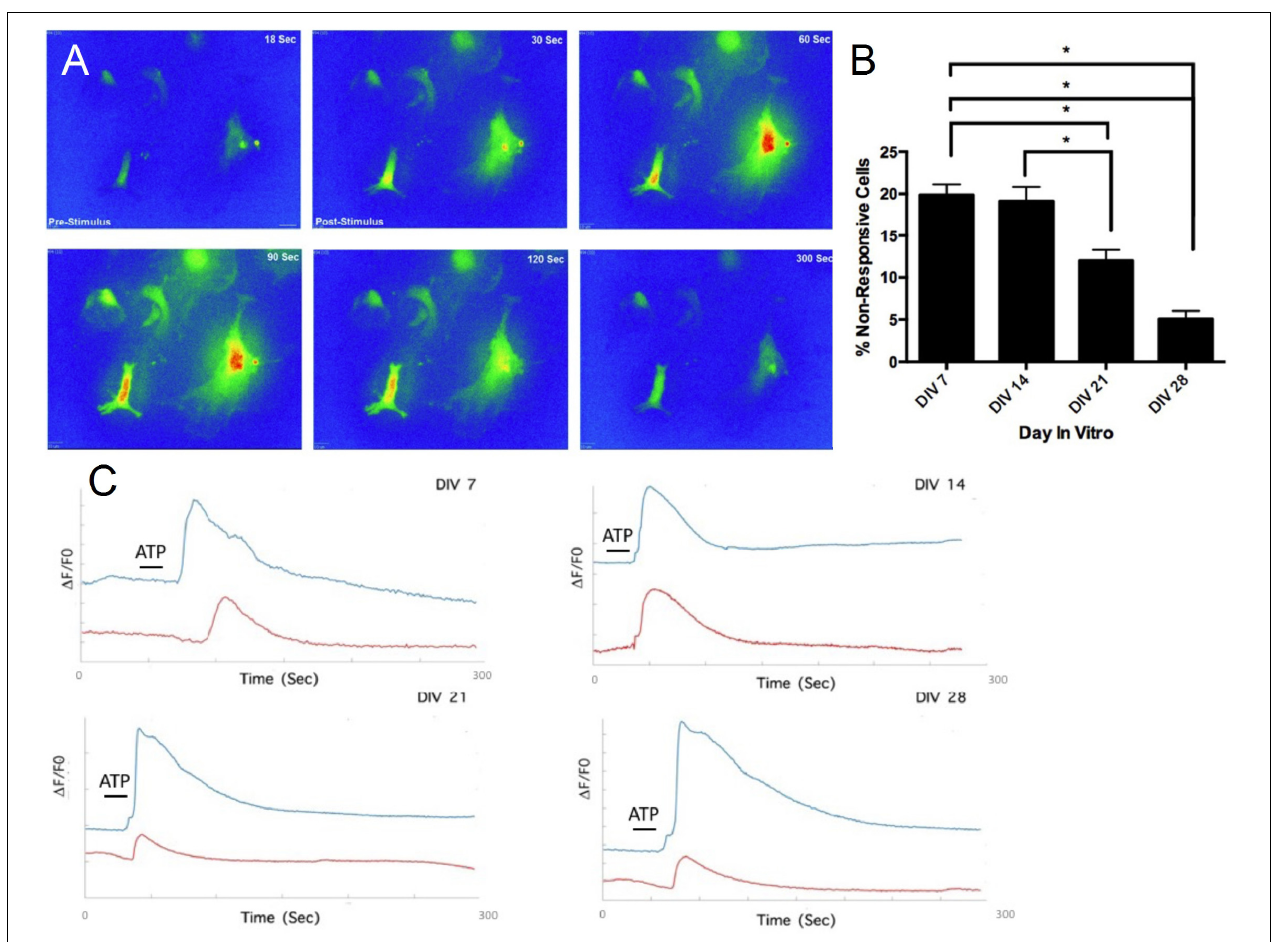
FIGURE 6 | Functional assessment of mESC derived astrocytes. (A) Time-lapse heat-map of activated astrocytes after stimulation (A) via adenosine triphosphate (ATP) (50 µ M). (B) Decrease in percentage of non-responsive cells after ATP stimulation, over the course of 4 weeks. (C) DIV 7-DIV 28 astrocytes treated with suramin exhibit stunted Ca 2 + responses after ATP application (red traces), compared to untreated astrocytes (blue traces), ∗ P <